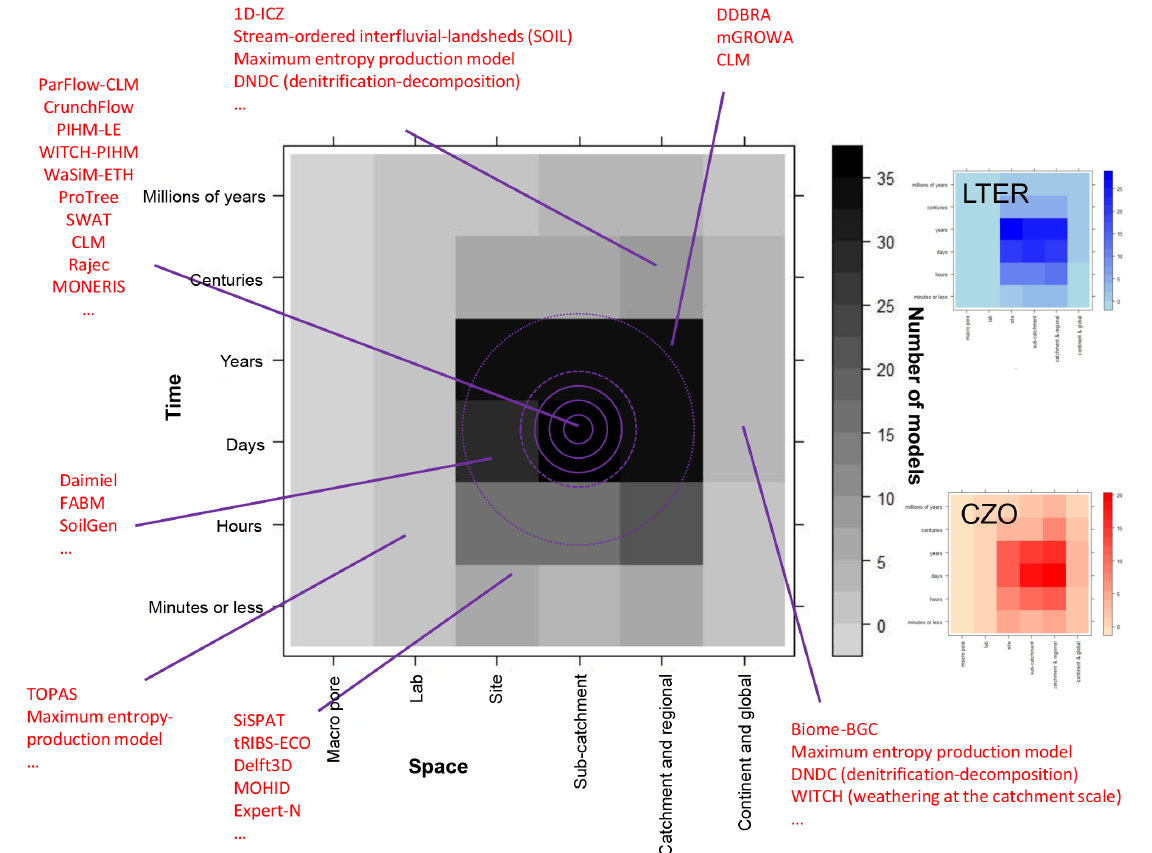
Figure 2. Heat map of model applications, with spatial and temporal dimensions of the surveyed models. Most models were denoted using several temporal and spatial scales. For visualization, we present some individual models at one exemplary instance. On the right, CZO and LTER model applications are presented